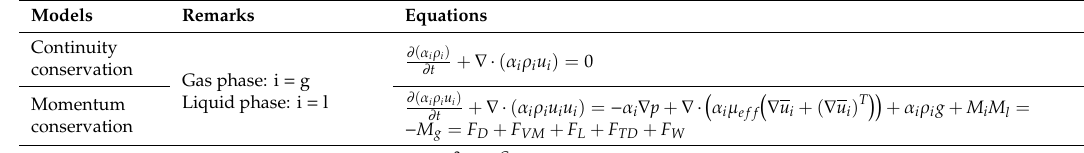
Table 2. Governing equations of the mathematical